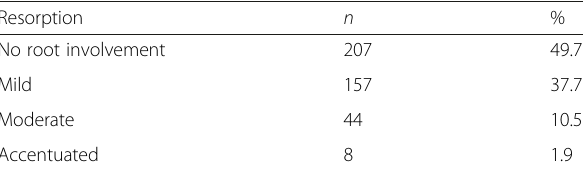
Table 4 Number and percentage of all evaluated teeth with the different levels of external apical root resorption Resorption